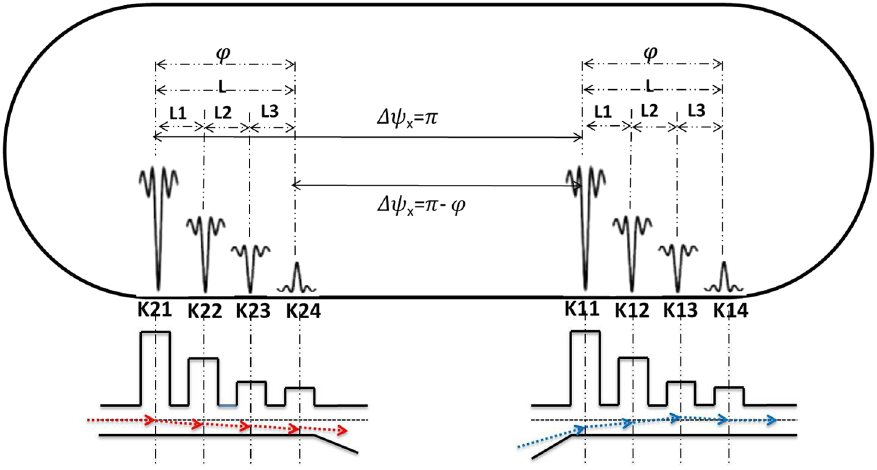
FIG. 14. Multicavity kick-drift tracking scheme with off-axis injection and extraction for flat-top waveform (the kick voltage is reversed at the last cavity as it is mainly used for curvature